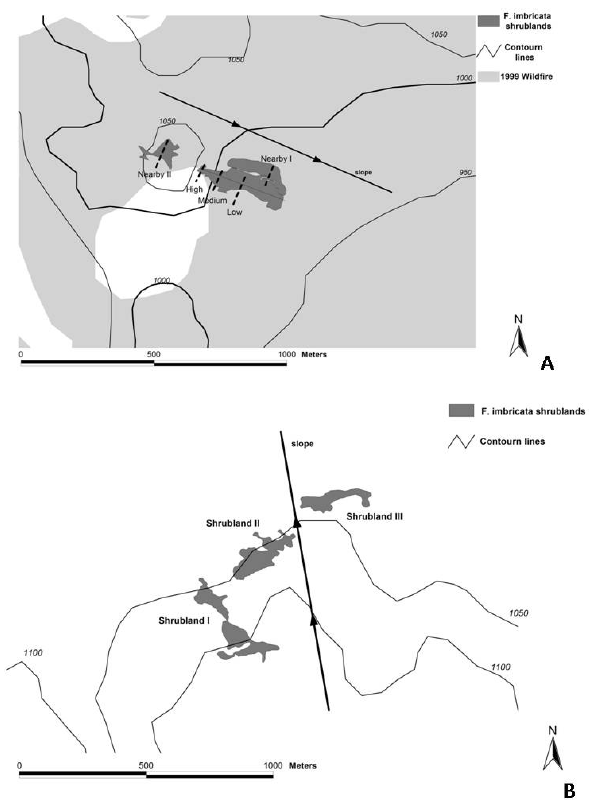
Fig. 4. Map showing in detail the location of the shrublands under study in relation to the 1999 fire and the topography. (A) Fire site. (B) Control site (this site was undamaged by the fire in 1999).